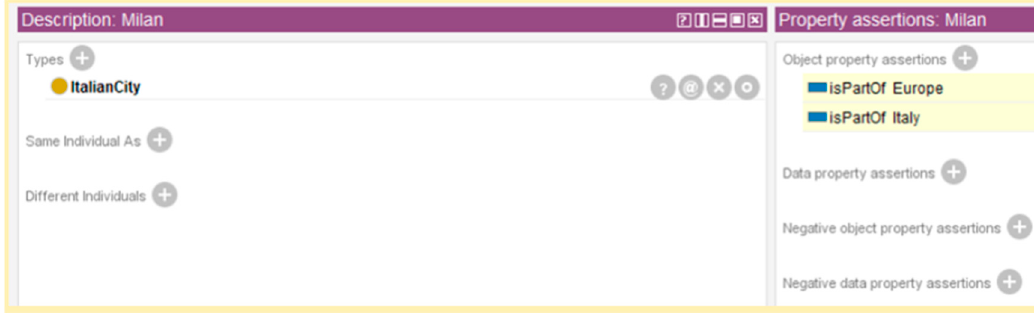
Figure 4. Milan individual property relations.